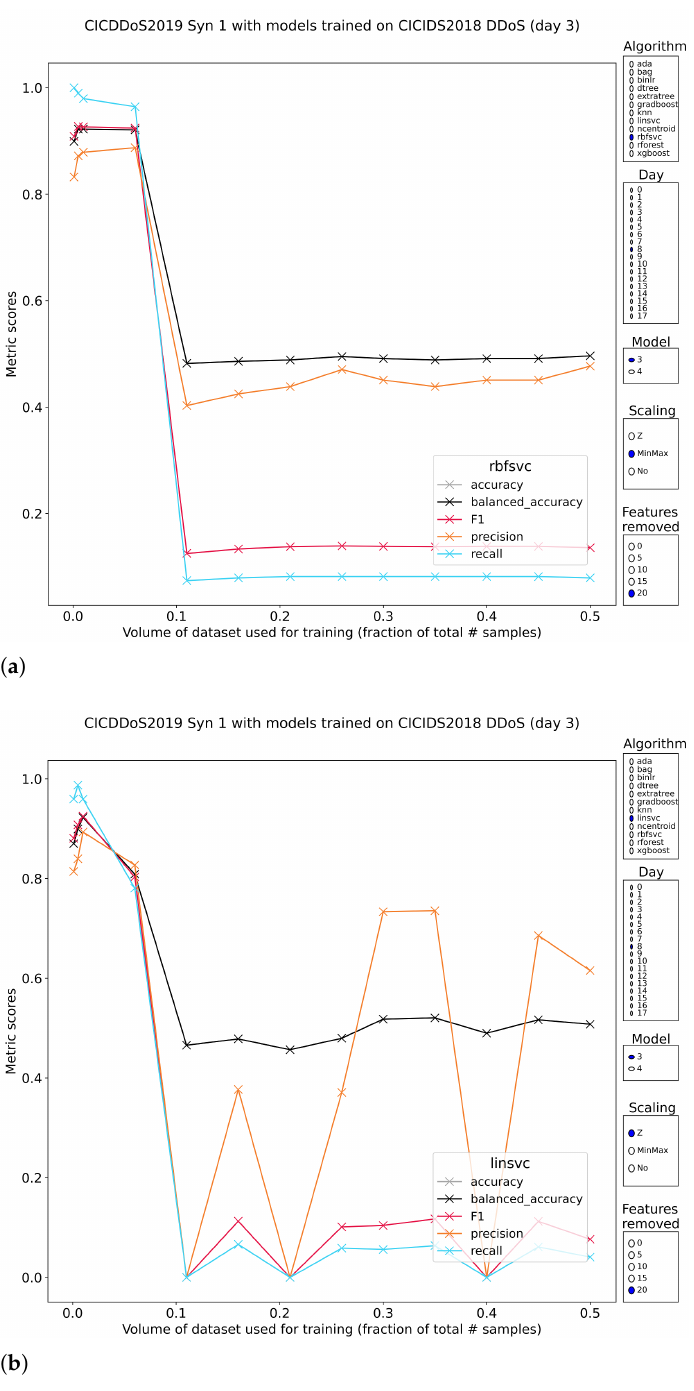
Figure 16. Another instance where, contrary to standard assumptions, increasing the training volume has a clear negative effect on generalized performance ( a , b